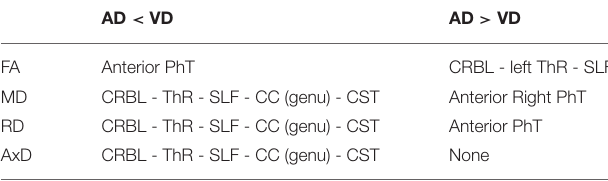
TABLE 5 | Diffusion changes between AD and